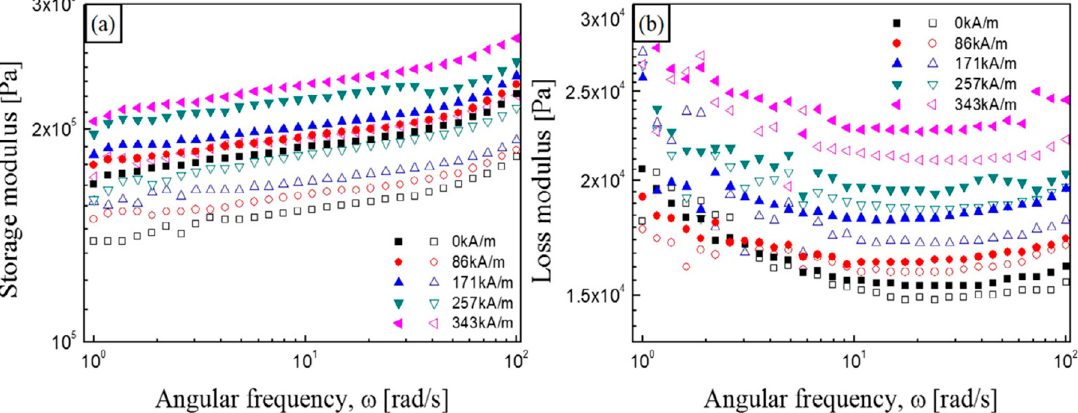
Figure 5. Frequency sweep test: storage modulus ( a ) and loss modulus ( b ) as a function of angular frequency for the anisotropic NR-based MR elastomers under various magnetic field strengths. (closed symbols: CI/(3-aminopropyl) triethoxy silane (APTES) MR elastomers; open symbols: pure CI MR elastomers) (reprinted with permission from [79], Copyright 2017 Elsevier B. V., New York, NY, USA).